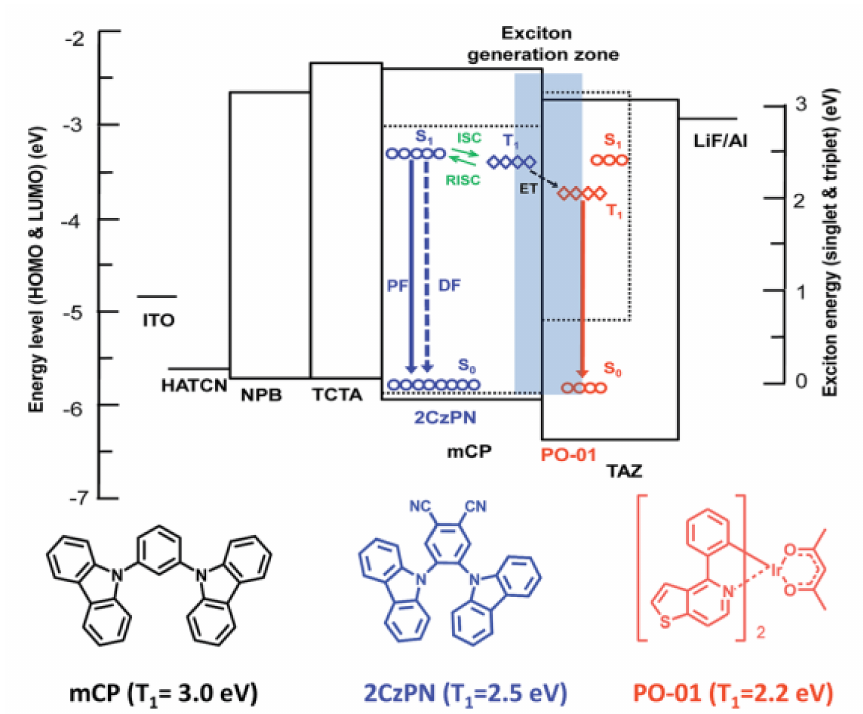
Figure 9. Schematic diagrams of the working mechanisms. The gray filled rectangle represents the main exciton generation zone. PF is the prompt fluorescence while DF is the delayed fluorescence. RISC indicates the reverse ISC and ET denotes the energy transfer. Reproduced with permission from [142], Royal Society of Chemistry,